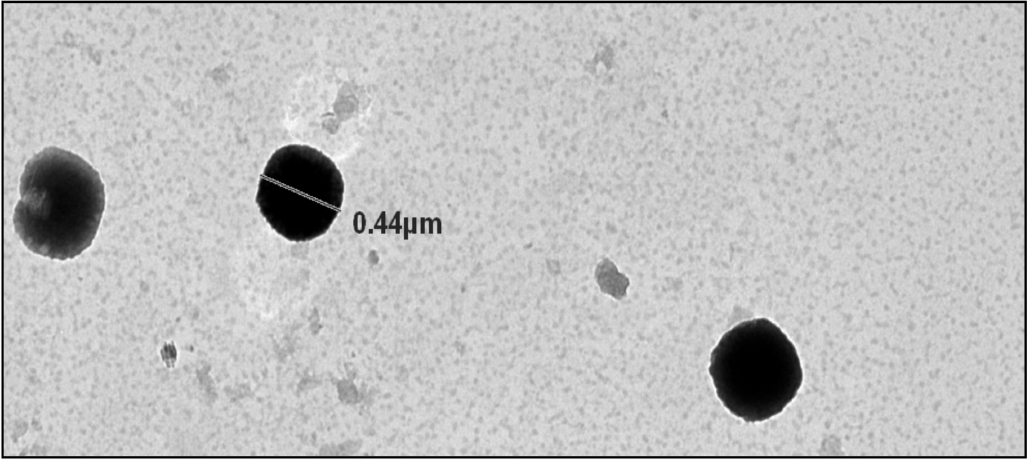
Figure 3. TEM image of